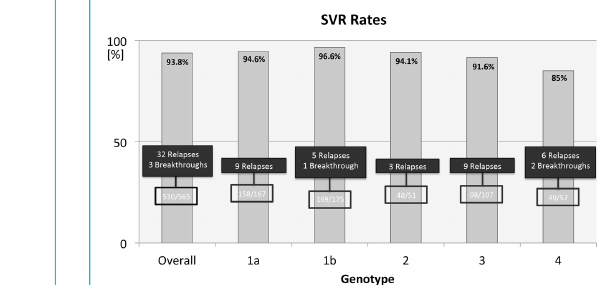
Figure 2: Overall SVR rate and SVR rates for individual HCV genotypes. Eight patients with not further specified genotype 1 are not included in this